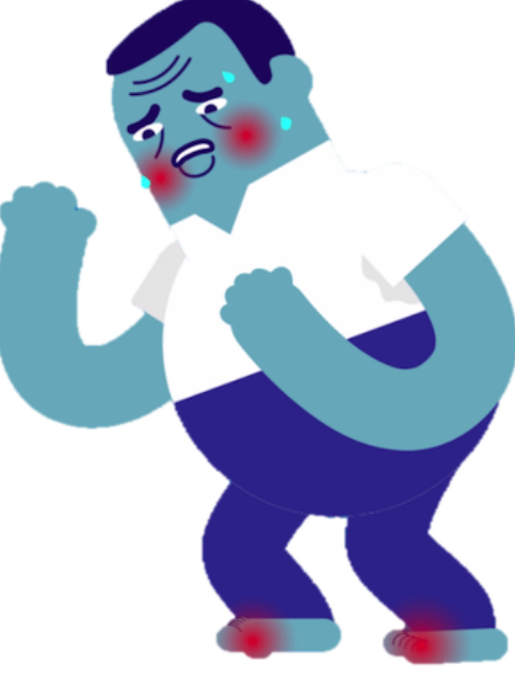
Figure 2. "Gout Man" as depicted in the animation video.